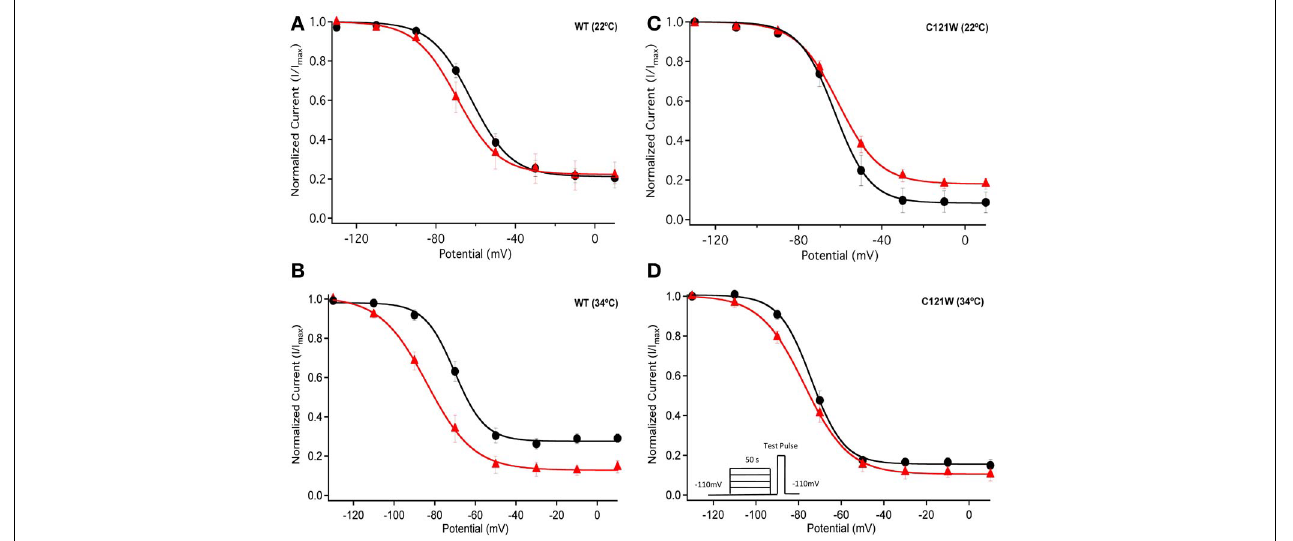
inactivation. The difference from the protocol used to measure steady-state fast inactivation is that the prepulse duration is longer (50s) and followed by a brief recovery pulse that recovers channels from fast inactivation prior to the test pulse.